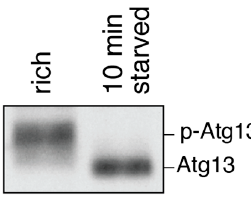
Figure 7. Atg13 is rapidly dephosphorylated upon starvation. Atg13 is highly phosphorylated (p-Atg13) under nutrient-rich conditions, but becomes dephosphorylated within minutes of nitrogen starvation. Cells were grown to mid-log phase (rich) and then nitrogen-starved for 10 min. Samples were prepared by TCA precipitation. Atg13 phosphorylation was determined by Western blotting using an Atg13-specific antibody. Note that complete dephosphorylation of Atg13 has been reported to occur within one minute of starvation [94].